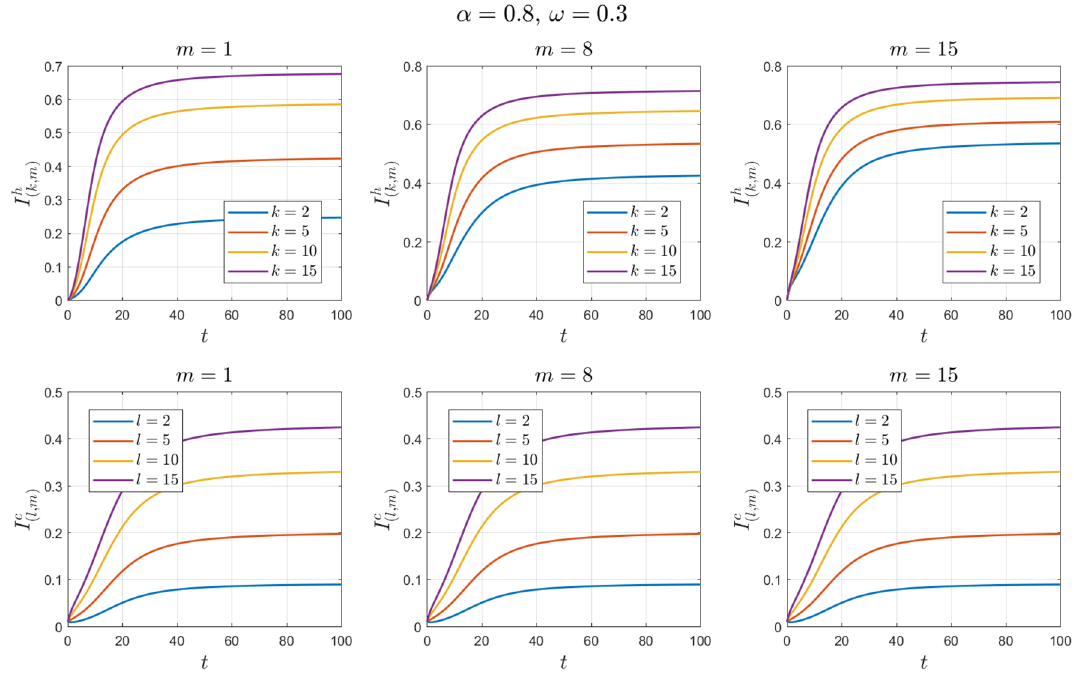
Figure 14. Numerical solutions of Example 5 for α = 0.8 and ω = 0.3 .